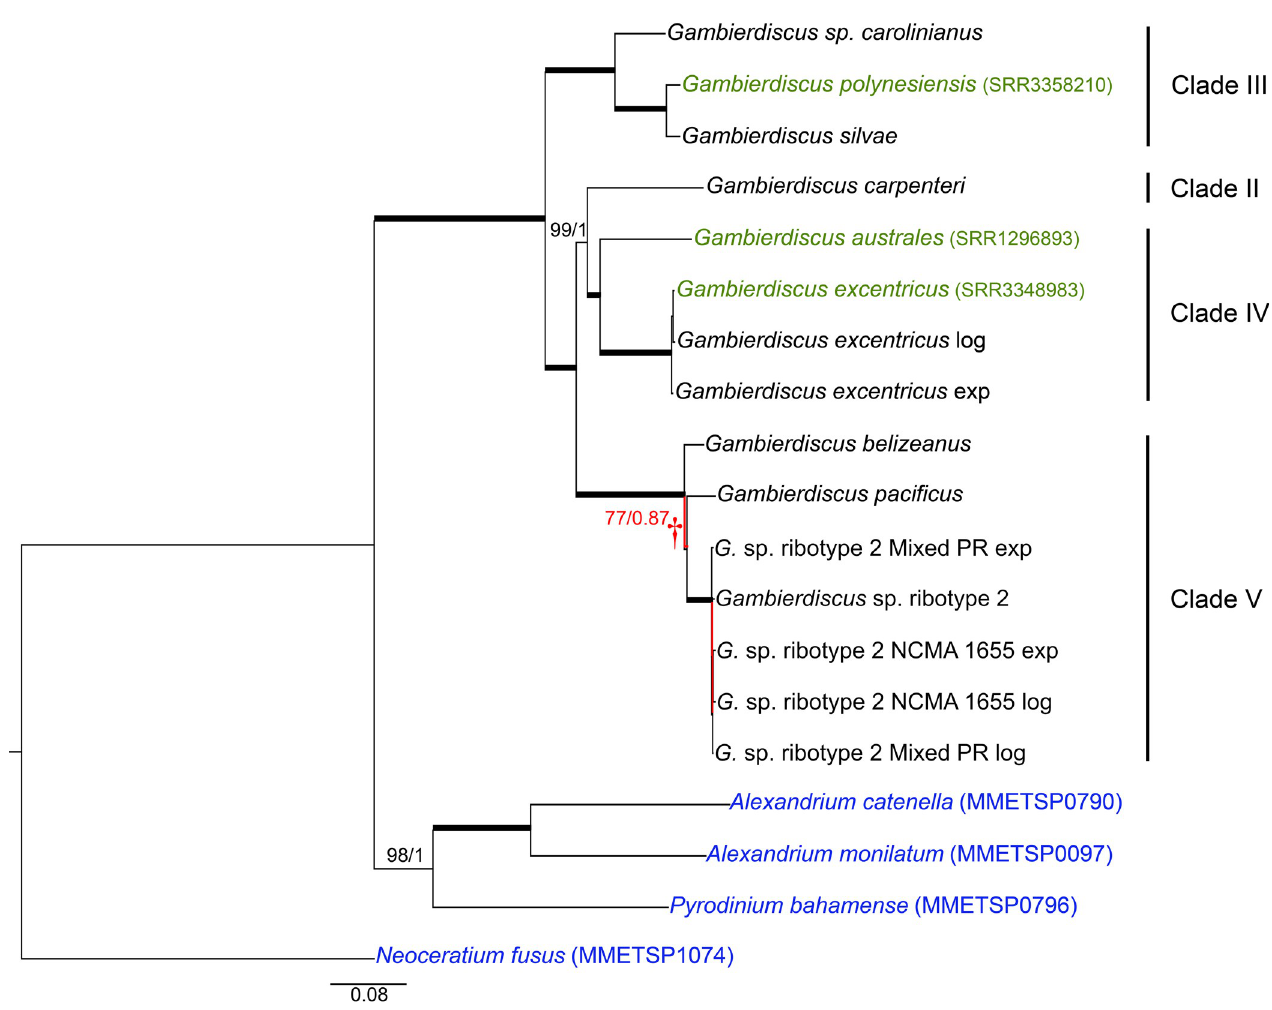
Fig 3. Phylogenetic tree of Gambierdiscus using transcriptomes and Core Eukaryotic reference genes. Maximum likelihood tree (found by RAxML), supported by Bayesian analysis. Branches indicated in red are not supported (ML bootstrap � 80%; Bayesian posterior probability < 1). Taxa in green indicate Gambierdiscus transcriptomes obtained from NCBI. Taxa in blue indicate outgroups, whose transcriptomes were also obtained from NCBI. SRA identifiers are found in parentheses next to the taxon name. Branch with low support (†) indicates a possible single common ancestor of G . belizeanus , G . pacificus , and G . sp. ribotype 2. Genes were chosen using the Core Eukaryotic Gene dataset (BUSCO and CEGMA) as reference. Nucleotide tree: 28 genes; 45,828 bp. There are 0.08 substitutions per site.